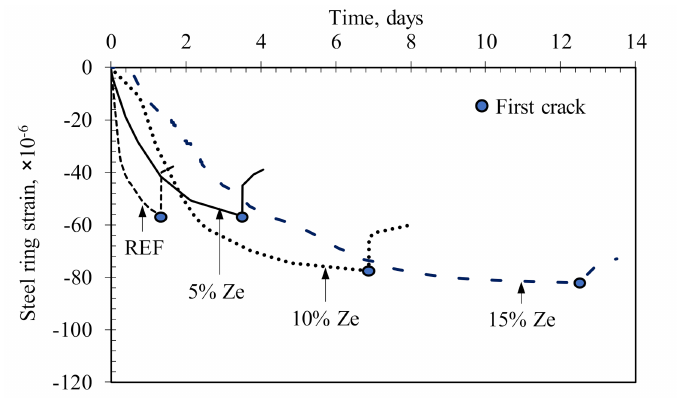
Figure 11. Deformation of steel rings in restrained shrinkage